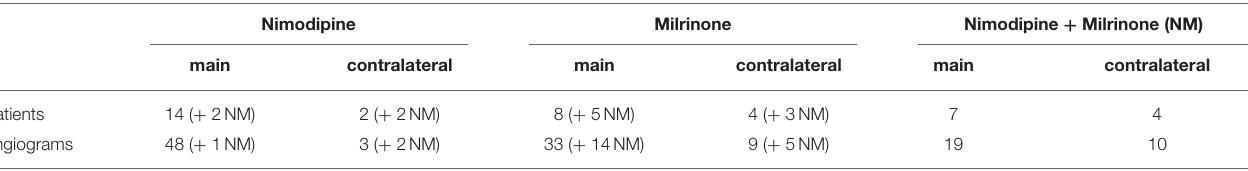
TABLE 3 | Drug-depended distribution of